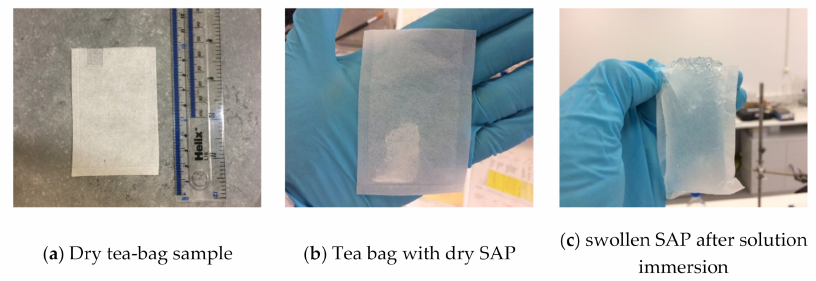
Figure 5. Tea-bag test ( a – c